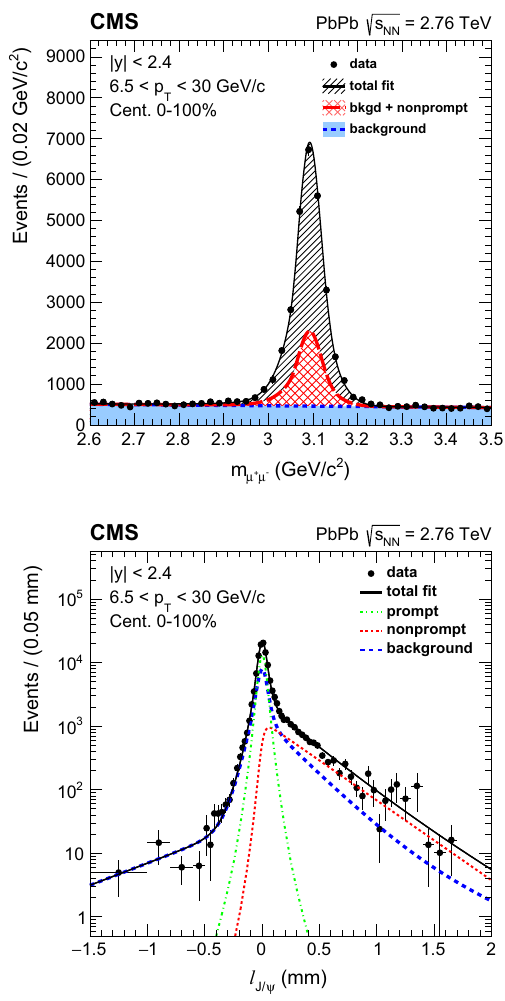
Fig. 1 Invariant mass spectra ( top ) and pseudo-proper decay length distribution ( bottom ) of μ + μ − pairs in centrality 0–100% and inte- grated over the rapidity range | y | < 2 . 4 and the p T range 6 . 5 < p T < 30GeV / c. The error bars on each point represent statistical uncertain- ties. The projections of the two-dimensional fit onto the respective axes are overlaid as solid black lines . The dashed green and red lines show the fitted contribution of prompt and nonprompt J /ψ . The fitted back- ground contributions are shown as dotted blue lines